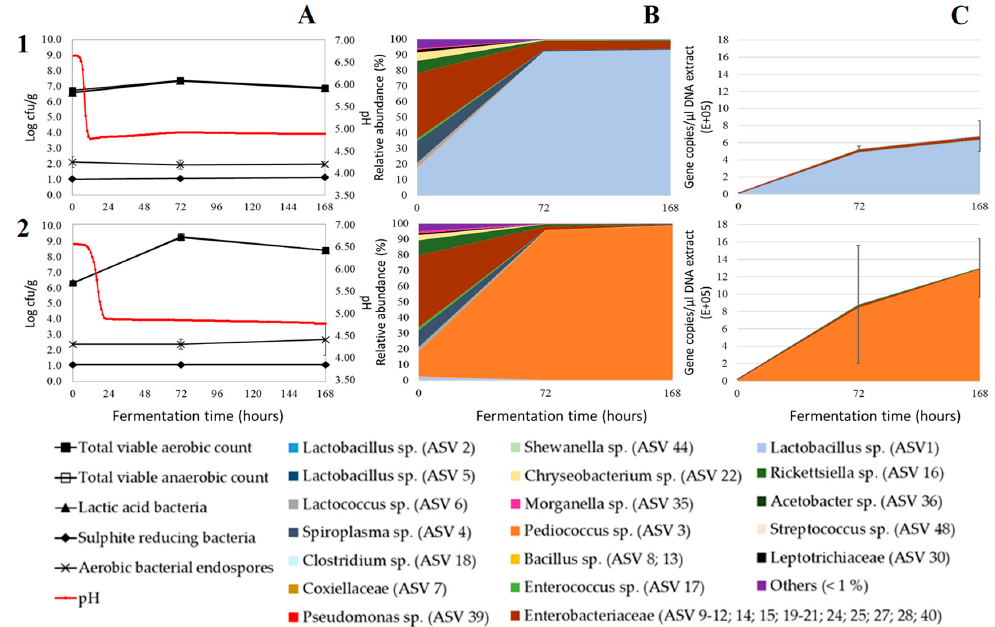
Figure 2. Microbial counts and pH ( A ), relative abundance in the bacterial community ( B ), and estimated absolute abundances (EAA) ( C ) during fermentation of pastes without sodium nitrite prepared from mealworms of the second production batch, and inoculated with starter Lactobacillus sakei ( 1 ) or Pediococcus acidilactici ( 2 ). The microbial counts and values of relative abundance and EAA are the mean of analyses performed on three replicate samples. Error bars represent the standard deviation. Only amplicon sequence variants (ASVs) represented by an average relative abundance of more than 1% of the sequences in any sample are shown. Other ASVs are grouped together in “others (<1%)”.